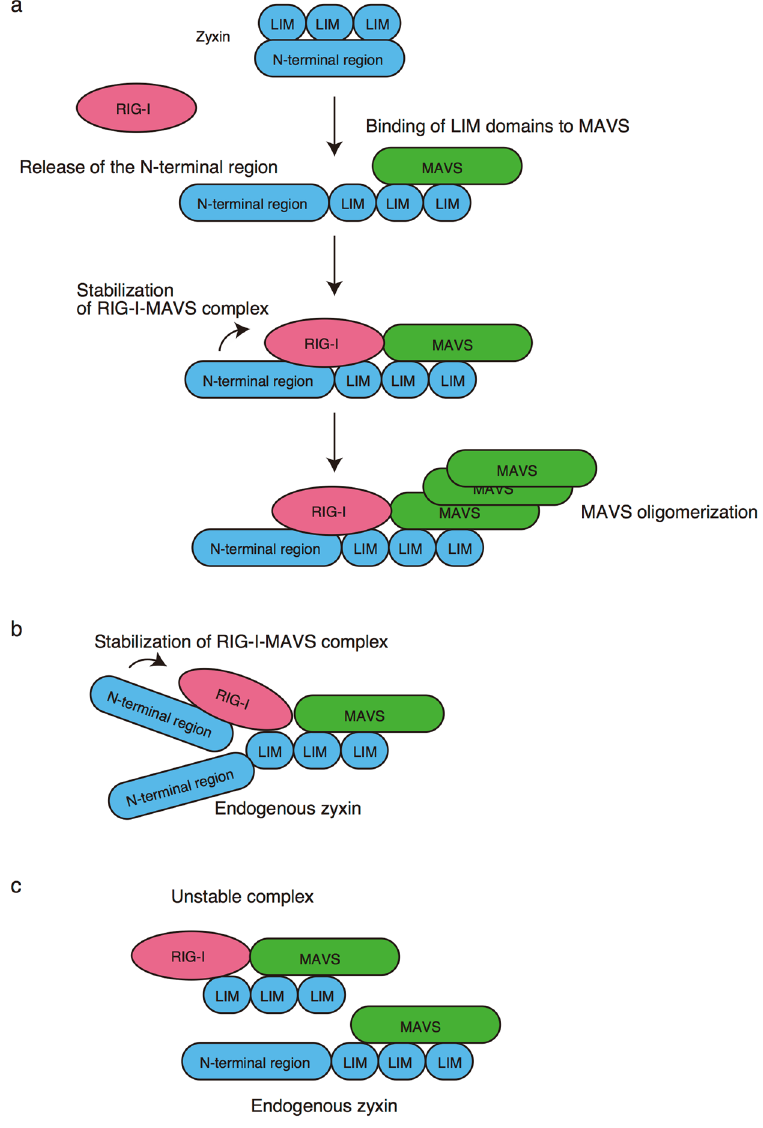
Figure 7. Model of zyxin-mediated stabilization of RIG-I-MAVS complex. ( a ) The C-terminal LIM domains of zyxin suppress the function of its N-terminal reigon. When the LIM domains bind to MAVS, the N-terminal region is released from its C-terminal region and bind to RIG-I, leading to stabilization of the RIG-I-MAVS complex required for MAVS oligomerization. ( b ) Ectopic zyxin-N expression can stabilizes the RIG-I-MAVS complex that includes endogenous zyxin. ( c ) Ectopic zyxin-C expression fails to stabilize the RIG-I-MAVS complex, because it lacks N-terminal